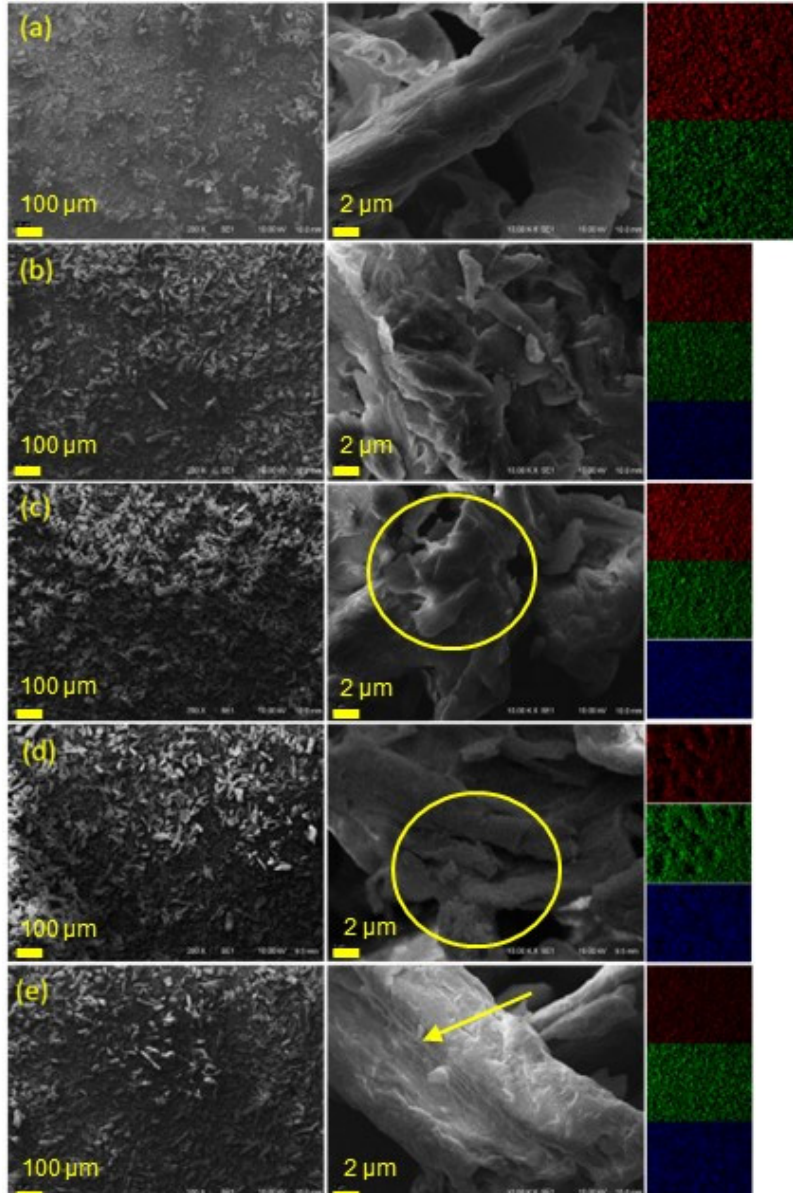
Figure 4. SEM micrographs and the respective EDS patterns (carbon = red, oxygen = green, chloride = blue) of ( a ) MCC, ( b ) MCC_C 4 , ( c ) MCC_HO 2 , ( d ) MCC_(HO 2 ) 2 and ( e ) MCC_C 2 OH.